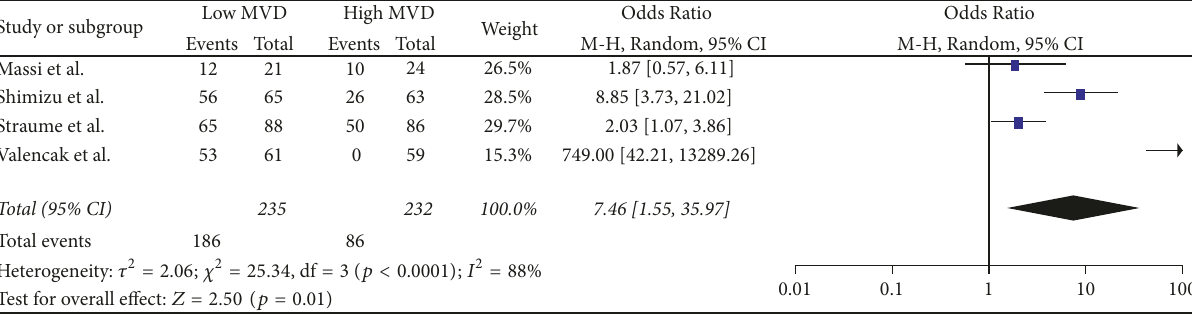
Figure 10: 60 months’ disease-free